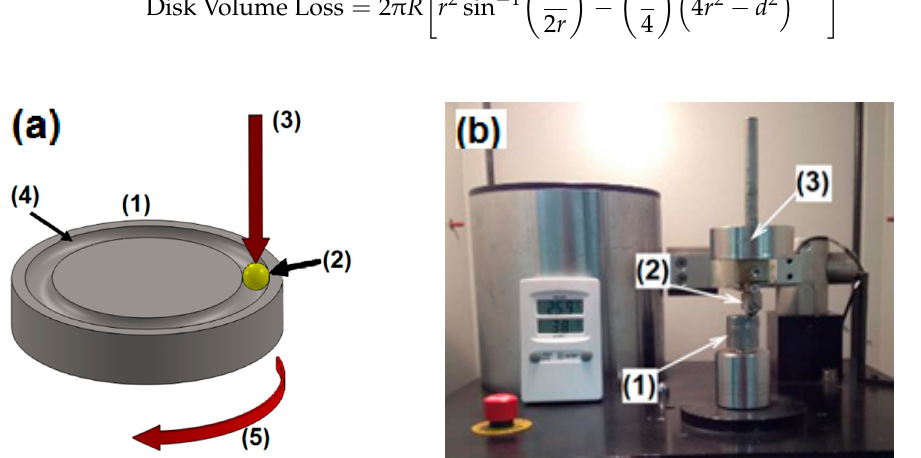
Figure 1: ( a ) scheme and ( b ) equipment for ball-on-disk testing, (1) sample, (2) ball, (3) load, (4) wear path on sample, and (5) rotation direction of sample.